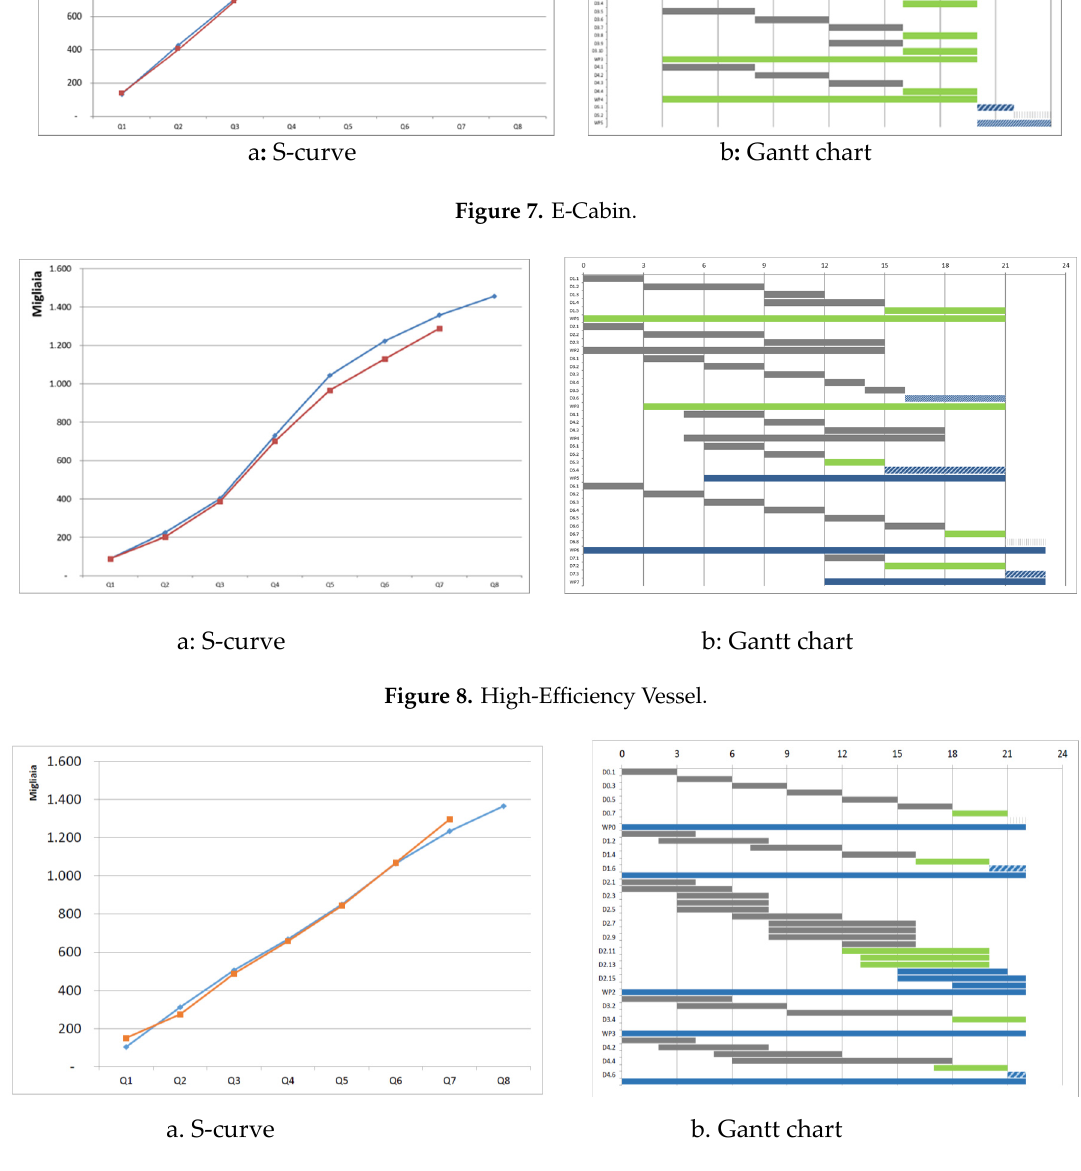
Figure 9 . Secure Platform . Figure 9. Secure